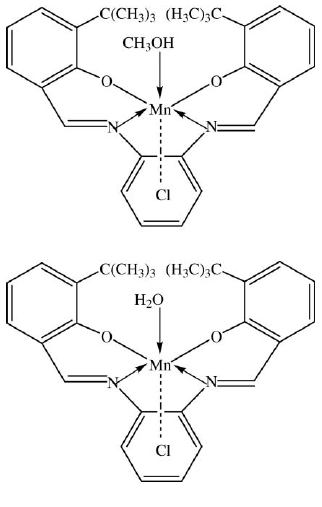
Data collection Bruker SMARTAPEX2 CCD area- detector diffractometer Absorption correction: multi-scan ( SADABS ; Bruker, 2005) T min = 0.791, T max = 0.981